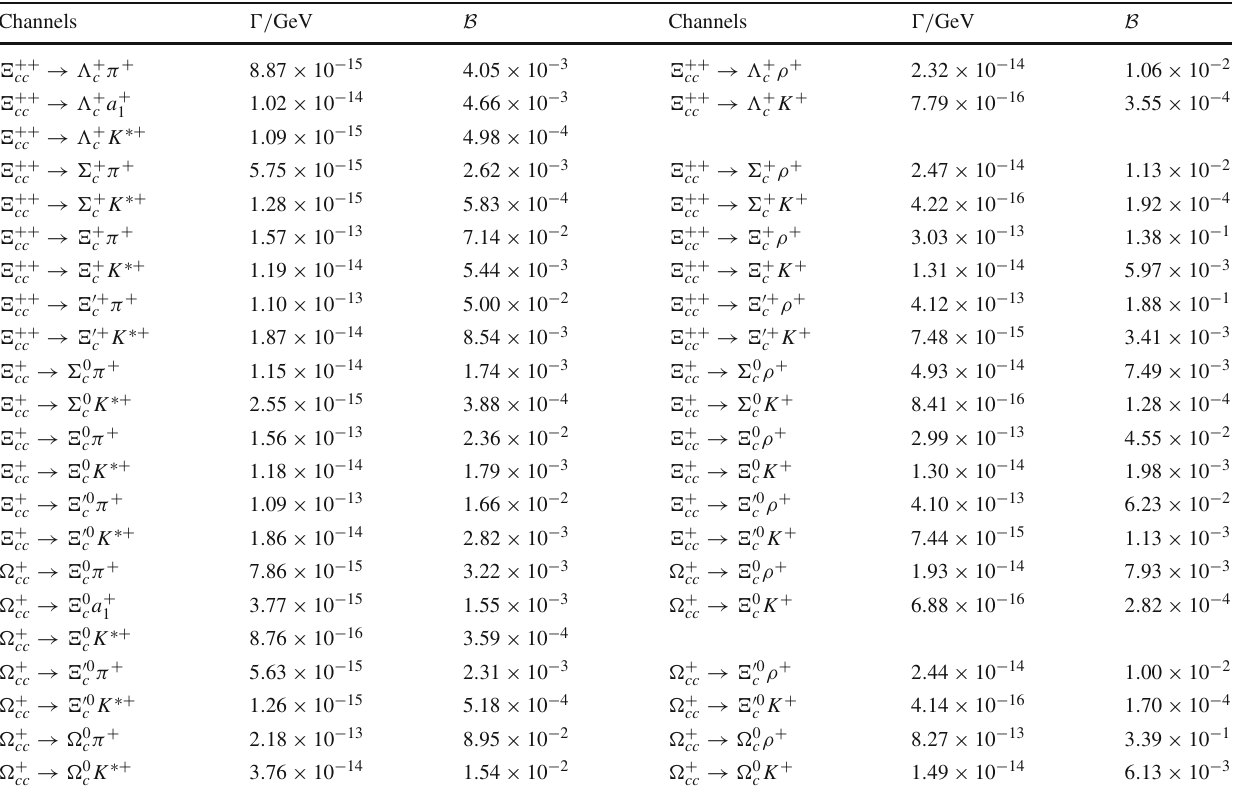
Table 23 Partial decay widths (in units of GeV) and branching ratios for nonleptonic decays of the doubly charmed